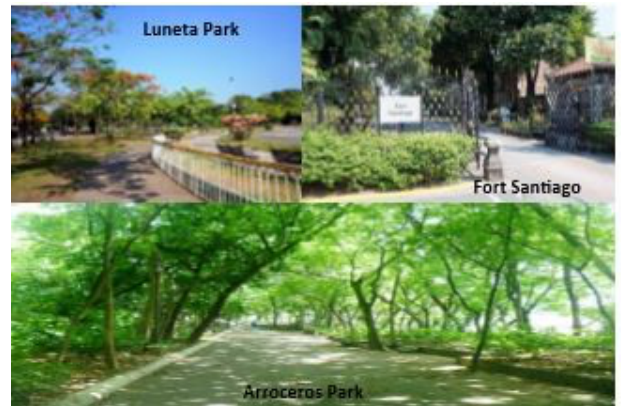
Figure 5. Selected photos of